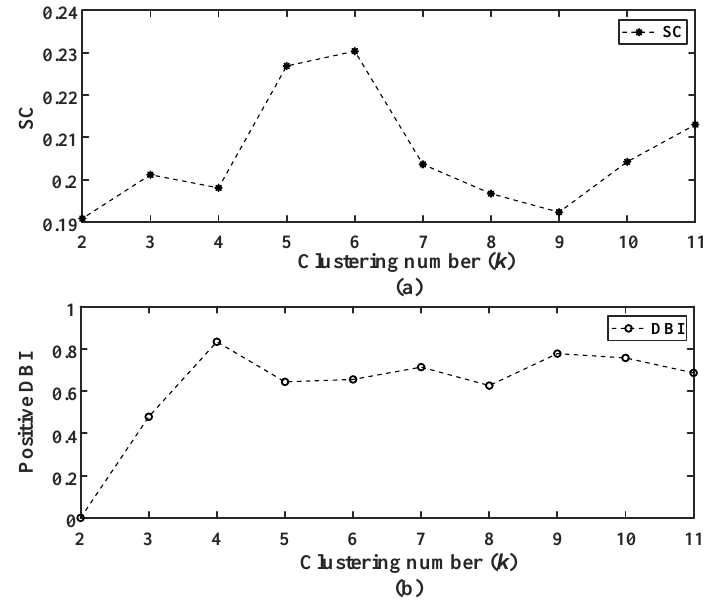
Figure 8. ( a ) SC and ( b ) positive DBI indexes under different clustering number k . According to the Equation (17), the positive ideal optimal solution Z + is (0.3543, 0.4136), and the negative ideal optimal solution Z − is (0.2928, 0). The comprehensive evaluation score calculated by the Equation (18) is shown in Figure 9.